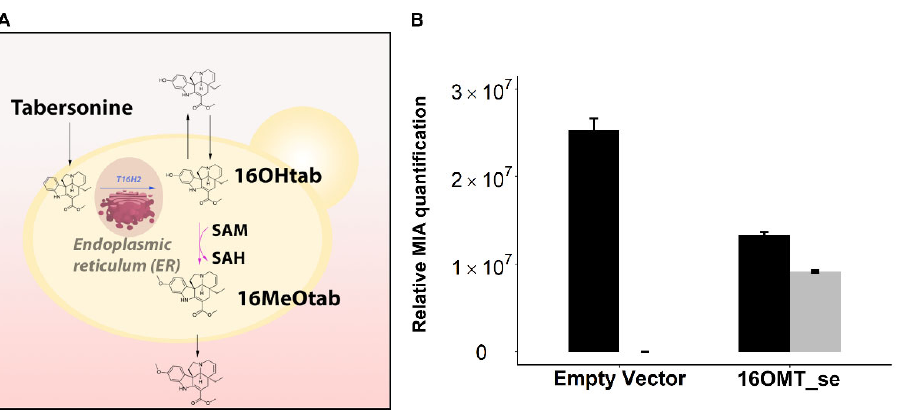
Figure 4. Cell permeability to 16 ‐ hydroxytabersonine (16OHtab). ( A ): Illustration of the pathway architecture in the inducible yeast strains from tabersonine to 16 ‐ methoxytabersonine (16MeOtab). ( B ): Permeability was evaluated by feeding yeasts (16OMT_se strain: episomal expression of 16OMT (se: single expression), Empty Vector: yeast strain harboring empty episomal plasmid) with 16 ‐ hydroxytabersonine. Alkaloids were quantified by UPLC ‐ MS in the yeast culture medium 24 h post ‐ feeding with 16 ‐ hydroxytabersonine (250 μ M). Black = 16 ‐ hydroxytabersonine, grey = 16 ‐ methoxytabersonine. Error bars correspond to the standard error of biological replicates ( n = 3). MIA composition of the yeast culture medium is expressed as relative peak